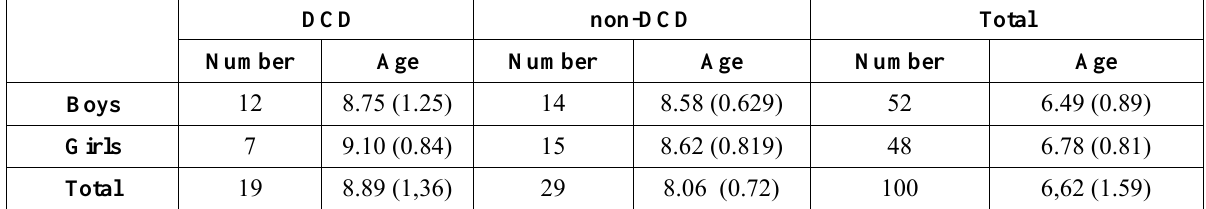
Group size with mean ages and standard deviations (SD) (N=100)